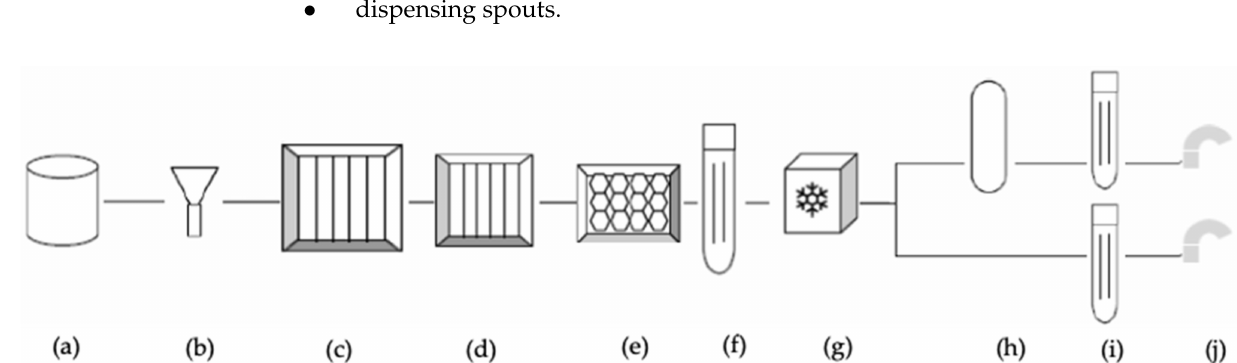
Figure 2. Process diagram of the water kiosks’ water supply chain: ( a ) water source—AQP, ( b ) pressure reduction system, ( c – e ) filters, ( f ) UV lamp, ( g ) cooler, ( h ) carbonation cylinder, ( i ) UV lamp, and ( j )